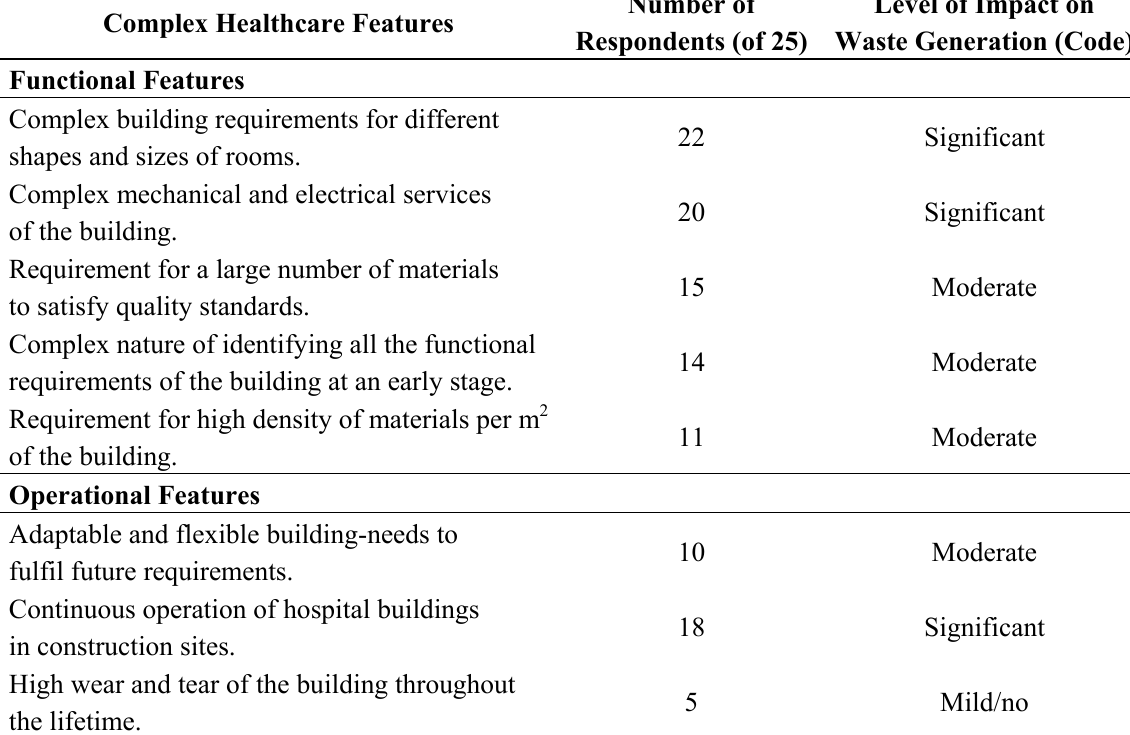
Table 2. Impact on healthcare complexities of waste